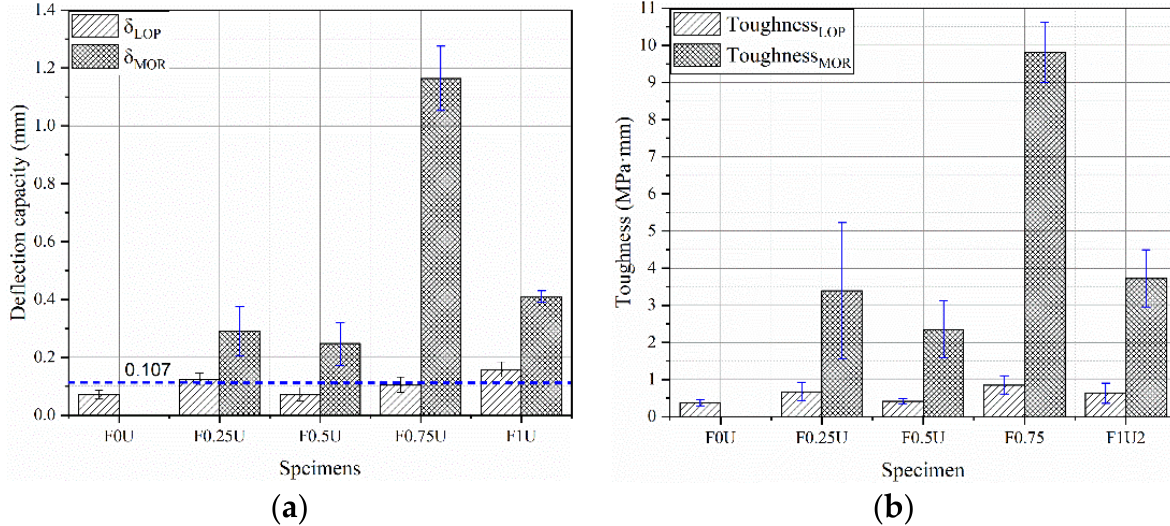
Figure 6. Deflection capacity ( a ) and toughness ( b ) of specimens. By studying the relationship between flexural strength and toughness (Figure 7),